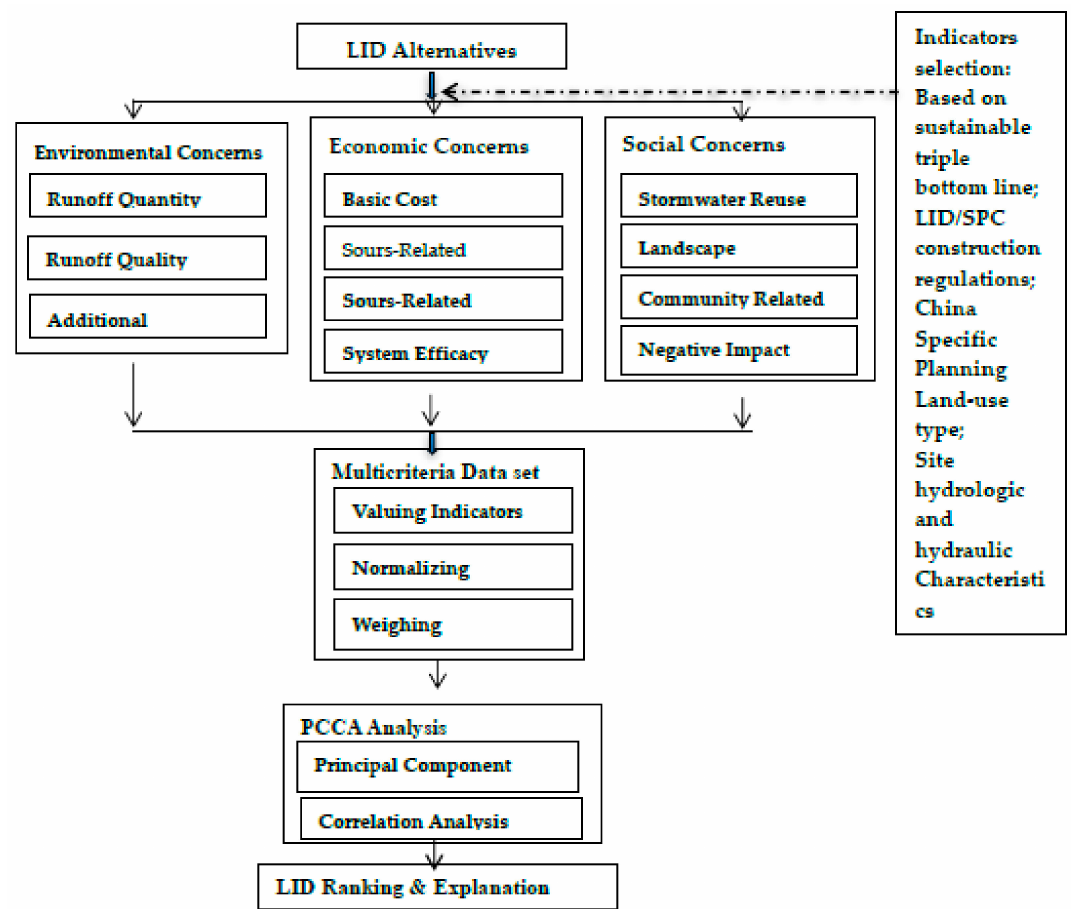
Figure 1. Low Impact Development (LID) Performance Evaluation